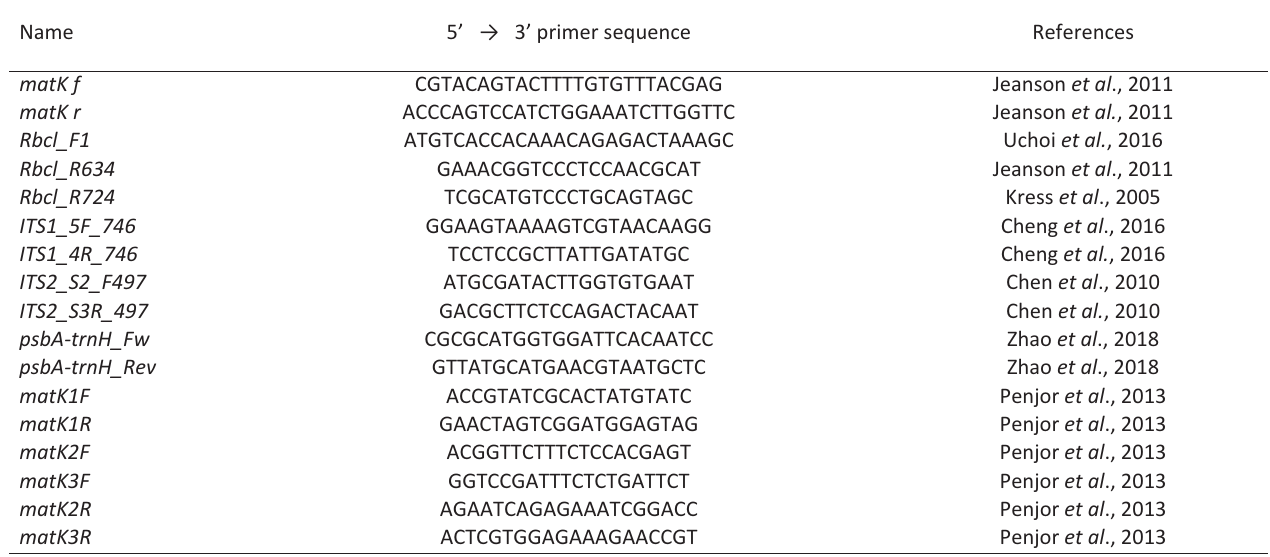
Table 3 - Universal primers sequence for barcoding used in this study